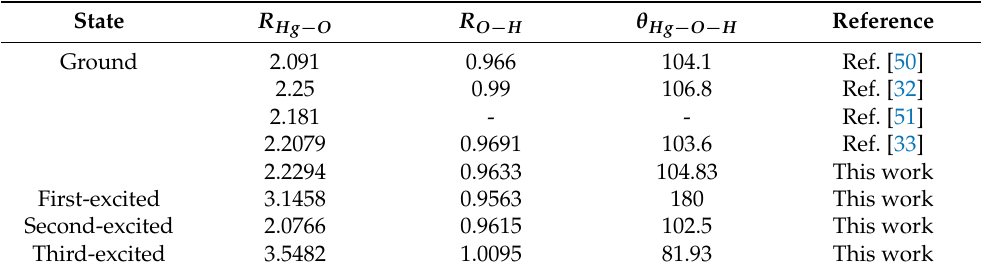
Table 1. List of the optimized geometry of the ground electronic state and three low-lying excited states of HgOH from various works. The unit of bond-lengths is angstrom (Å), while that of the bond angle is